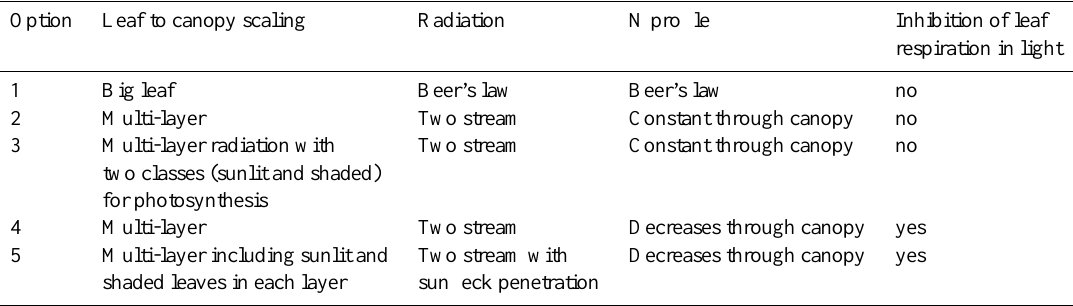
respiration in light